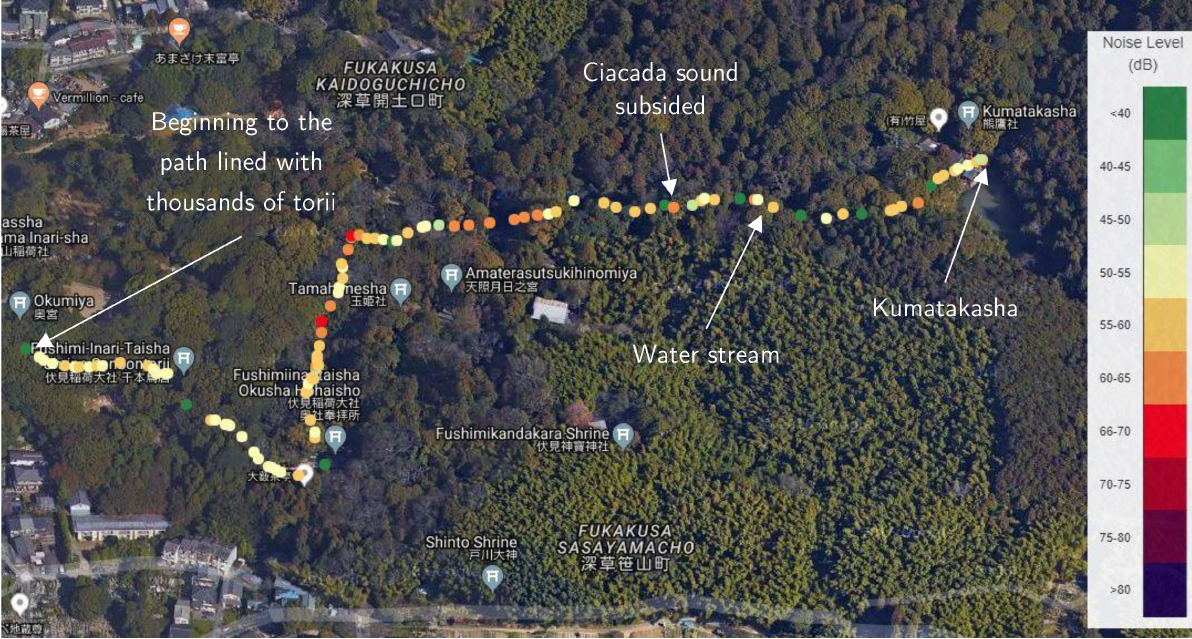
Figure 9: Soundscape from the starting of the torii gates to Kumatakasha